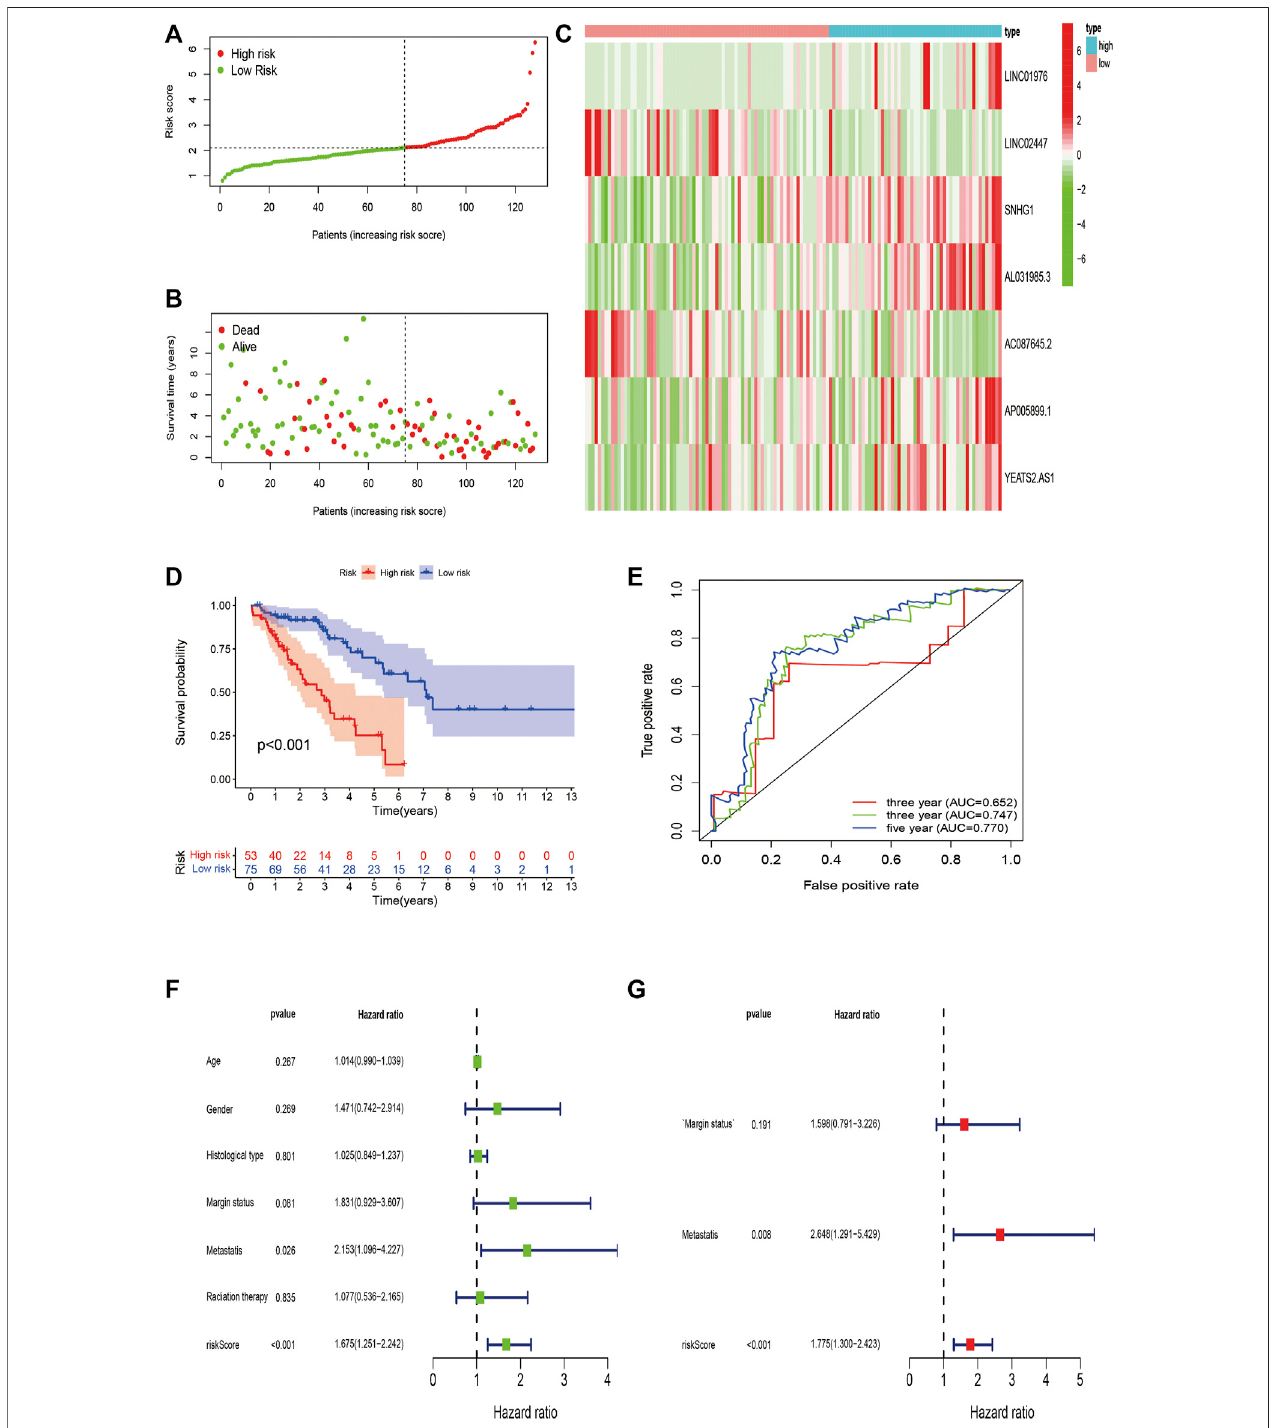
FIGURE 7 | Validation of m6A-Related lncRNAs-Based Risk Signature in STS. (A,B) Risk score and survival status of each patient in the training validation cohort. (C) Heatmap of 7 m6A-related lncRNAs in the validation cohort. (D) Kaplan – Meier analysis of patients in the high risk and low risk groups in the validation cohort. (E) Time-dependentROCanalysisofriskscoreinpredictingprognoses. (F,G) UnivariateandmultivariateCoxanalysesoftheriskscoreandclinicalvariablesinthevalidation cohort.